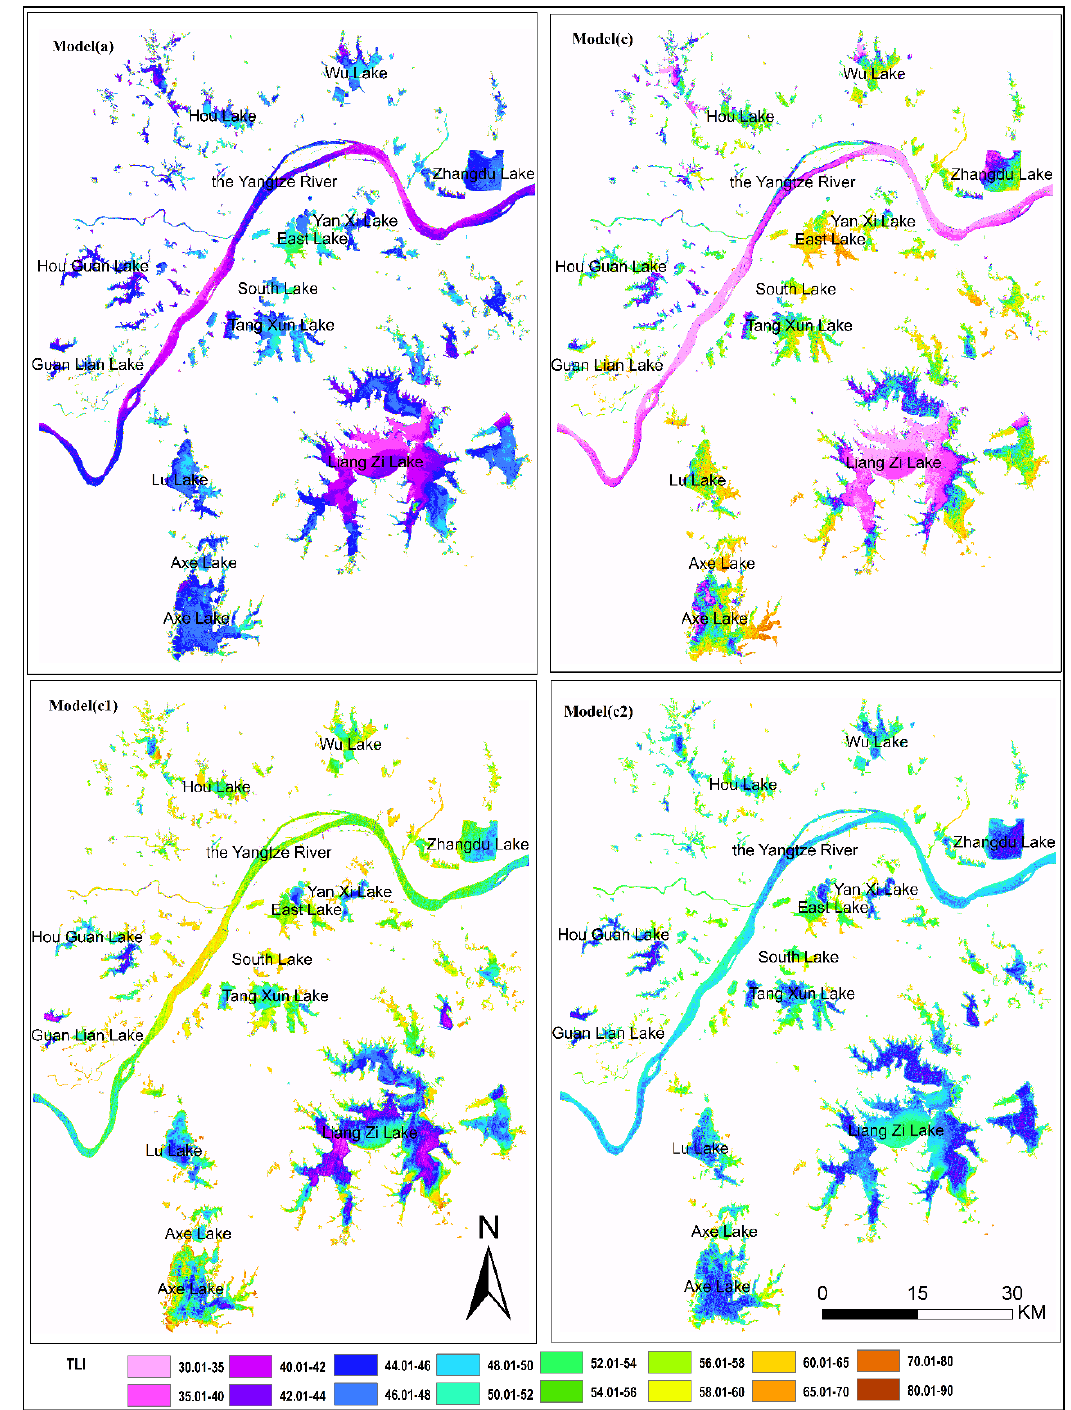
Figure 6. Distribution of TLI-retrieved data based on single bands and atmospheric parameters.